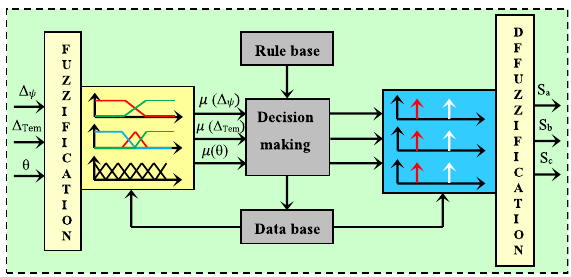
Fig. 7 Structure of the fuzzy switching